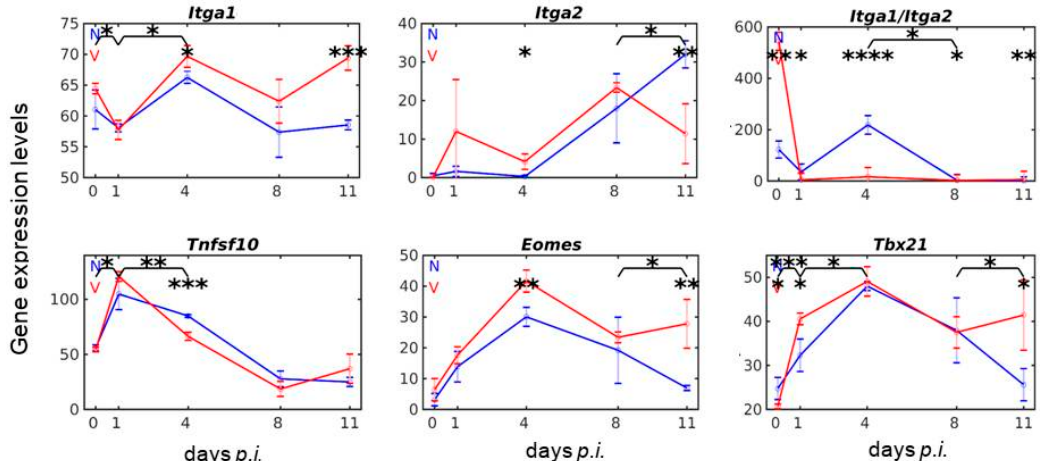
Figure 1. Time courses of hepatic expression of genes associated with liver-resistant natural killer (lrNK) cells and conventional natural killer (cNK) cells. RNA was isolated from individual livers prepared from vaccination-protected (V, red) and non-vaccinated (N, blue) mice infected with Plasmodium chabaudi blood-stage malaria on days 0, 1, 4, 8, and 11 p.i . Gene expression levels in linear scale are plotted as the means of three microarrays ± SD. The number of “*” marks over interval lines between sampling points and over the sampling points indicate statistical significance of corresponding intervals and of given sampling points, respectively, between vaccinated and non-vaccinated mice: * p < 0.05; ** p < 0.01; *** p < 0.001; **** p < 0.0001.